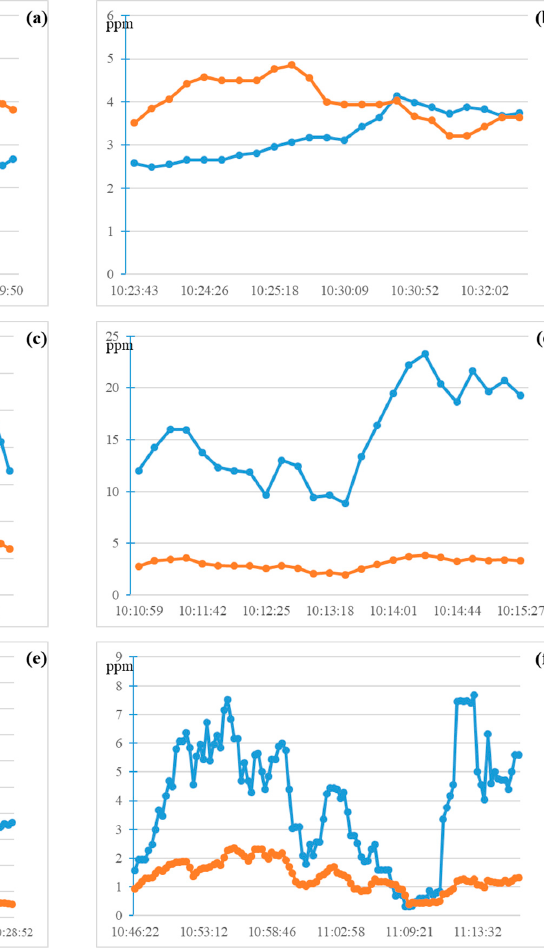
Figure 6. Measurement concentrations (ppm) of SO 2 (blue solid line) and NO 2 (orange solid line) in ship plumes during field testing of the rotary unmanned aerial vehicle: ( a ) plume 1, 09:52 to 09:59, 1 March 2018; ( b ) plume 2, 10:23 to 10:32, 1 March 2018; ( c ) plume 3, 15:13 to 15:23, 1 June 2018; ( d ) plume 4, 10:10 to 10:15, 21 June 2018; ( e ) plume 5, 10:09 to 10:28, 22 June 2018; and ( f ) plume 6, 10:46 to 11:13, 22 June 2018.